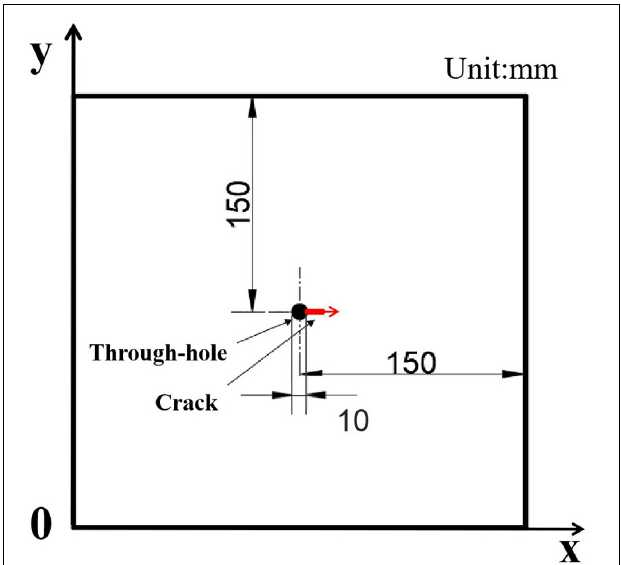
FIGURE 3 | The schematic diagram of through-hole on the aluminum